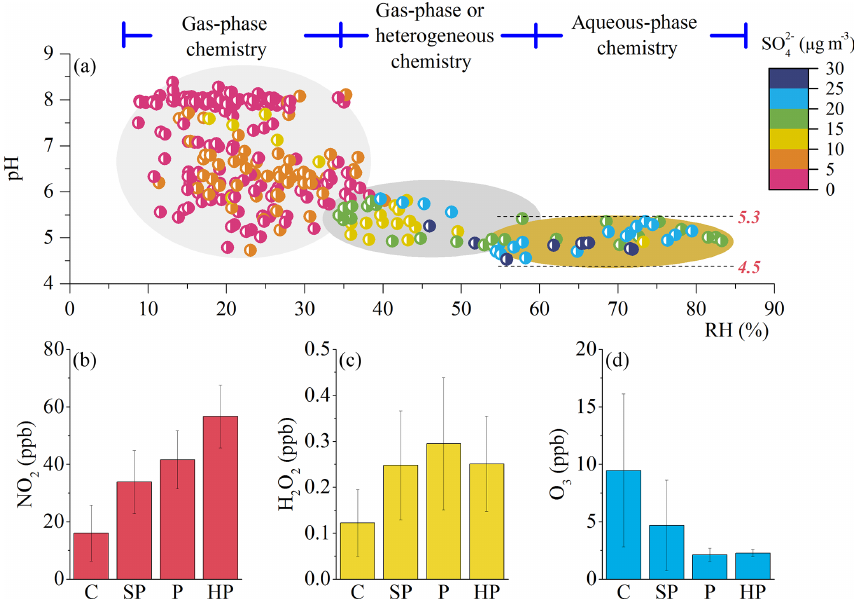
Figure 5. (a) The correlations among aerosol pH, atmospheric RH and atmospheric SO 2 − H 2 O 2 and O 3 under different pollution conditions – clean (C), PM 2 . 5 < 35µgm − 3 ; slightly polluted (SP), 35µgm − 3 < PM 2 . 5 < 75µgm − 3 ;